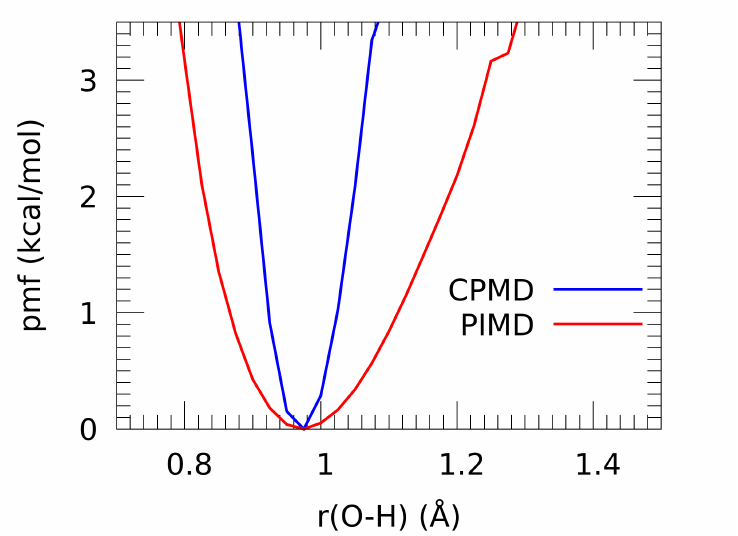
Figure 9. Temperature dependence of ( a ) dipole moment power spectra corresponding to the IR absorption, ( b ) vibrational signatures of the –OH proton atoms—results of Car–Parrinello molecular dynamics simulations.